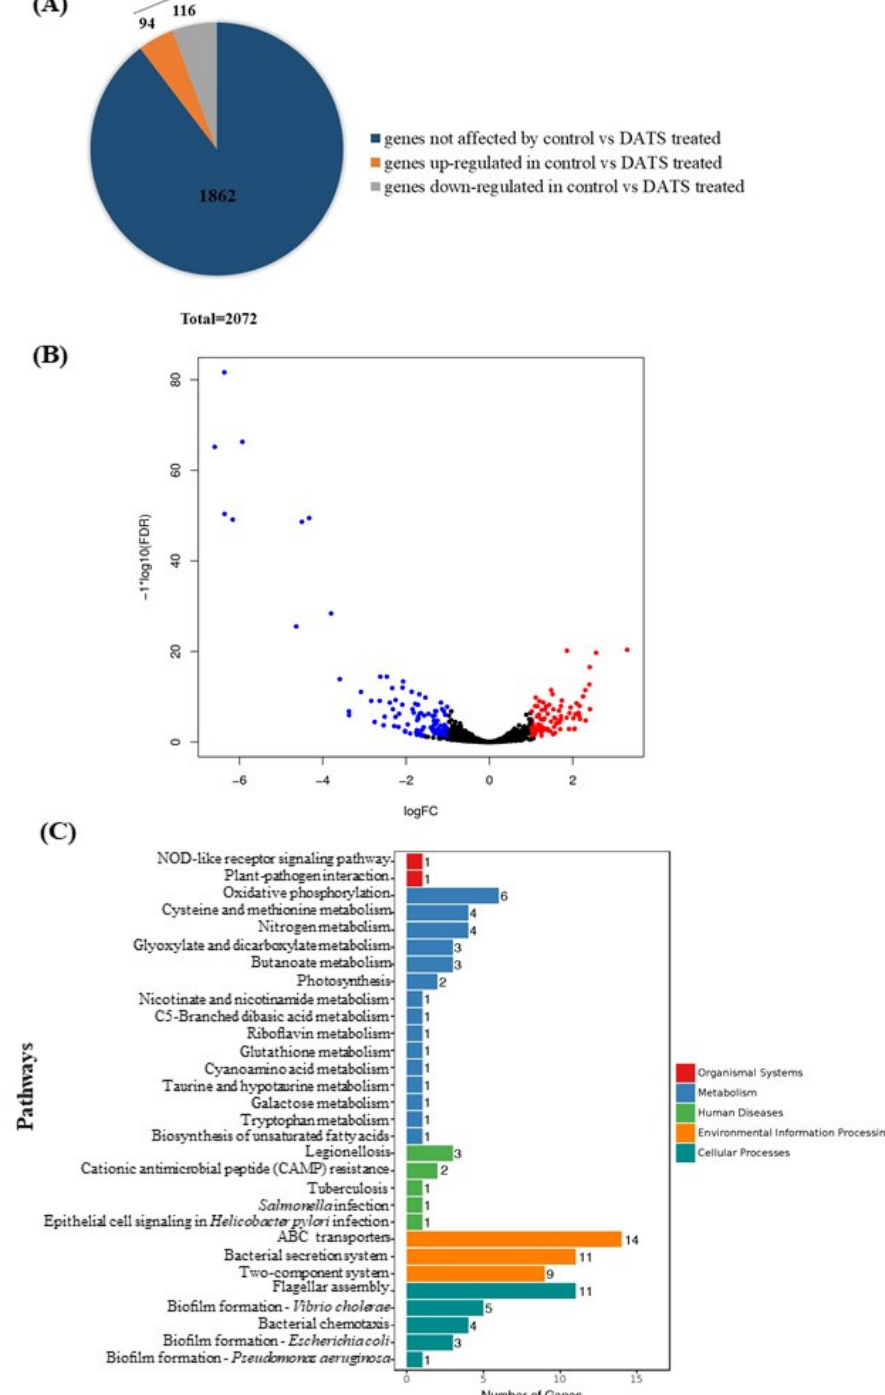
Figure 4. Transcriptional analysis of C. jejuni strain 81-176 under 16 µ g/mL DATS treatment. ( A ) The distribution of total differentially expression genes (DEGs), which blue color represented genes not affected by DATS; orange color represented upregulated genes under DATS treatment; ad gray color represented downregulated genes under DATS treatment. ( B ) The volcano plot for global comparison of transcription profiles between DATS treatment and the control. Red spots represented upregulated genes under DATS treatment; blue spots represented downregulated genes under DATS treatment. ( C ) Statistical enrichment of DEGs in the KEGG pathway.